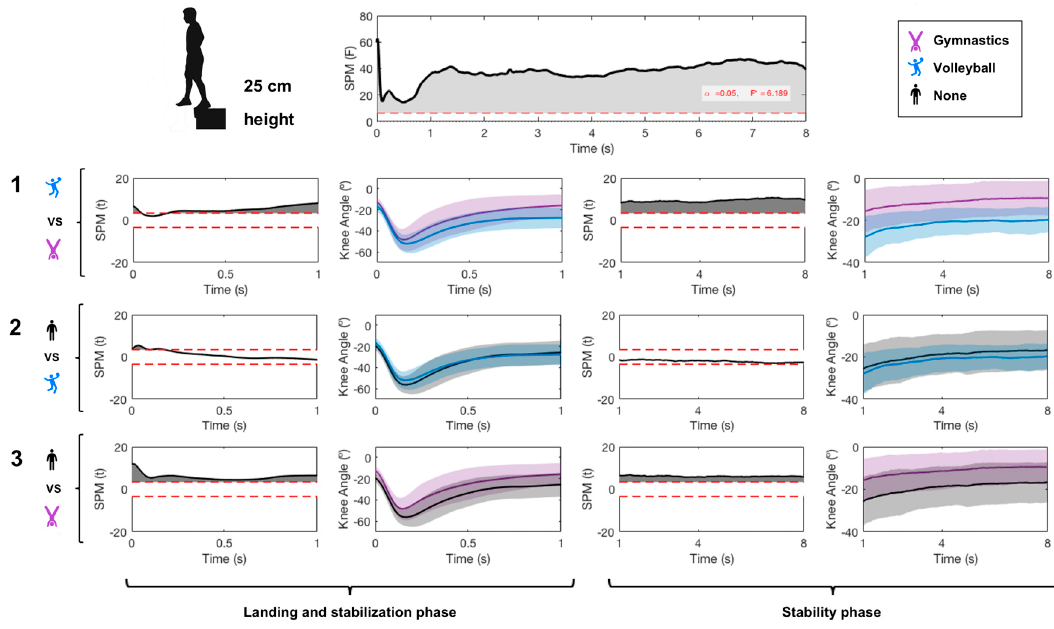
Figure 4. Effect of sports practice on knee angle in the sagittal plane. SPM refers to statistical parametric mapping. Data acquired during landing and stability phases of single-leg landing from 25 cm height for 8 s are shown and compared. 1 refers to the pairwise comparison between gymnastics and volleyball groups; 2 refers to the pairwise comparison between volleyball and control groups; 3 refers to the pairwise comparison between gymnastics and control groups. An angle lower than 0° indicates knee flexion.